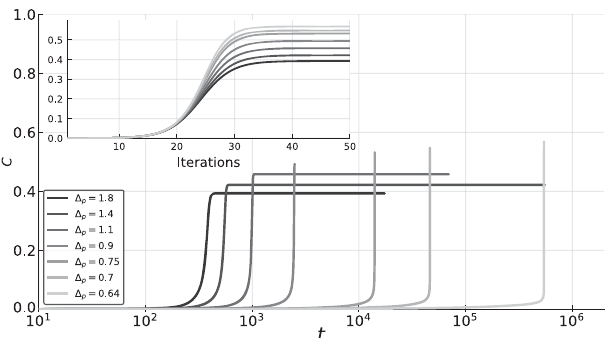
1 . The main panel p ¼ ¯ C ð t ¼ 0 Þ ¼ 10 − 40